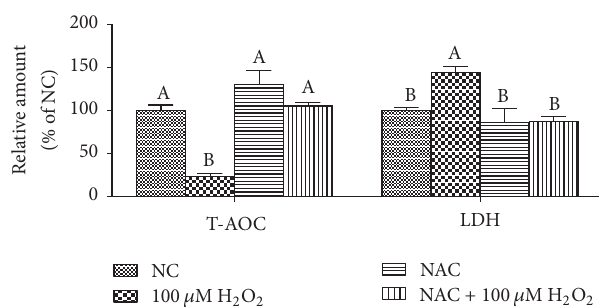
Figure 5: The concentrations of T-AOC and LDH in the IPEC-J2 cells.Cellsweretreatedwith0(NC)or800 𝜇 MNACand0or100 𝜇 M H 2 O 2 , respectively. Data were expressed as means ± SEM of at least three independent experiments. a–b Values with different letters are significantly different ( 𝑃 < 0.05